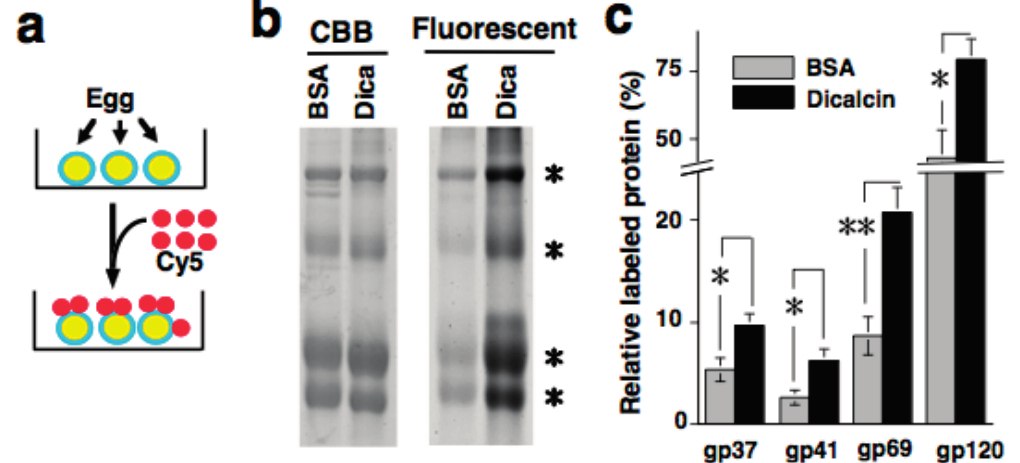
Figure 3. Dicalcin-binding to frog ZPC changes the three-dimensional structure of the entire ZP ( a ) Schematic representation of in vivo labeling of the frog ZP with fluorescent dye; ( b ) After preincubation either with bovine serum albumin (BSA) or dicalcin, labeled ZP proteins were electrophoresed and fluorescent images were obtained, followed by quantification of the amount of each ZP protein ( asterisks ); ( c ) The ratio of the molar amount of labeled protein to the total amount existing in the preparation was calculated for each frog ZP protein ( n = 8–10; *, p < 0.02; **, p = 0.002). Reproduced from Miwa et al ., (2010) [12] with permission of the